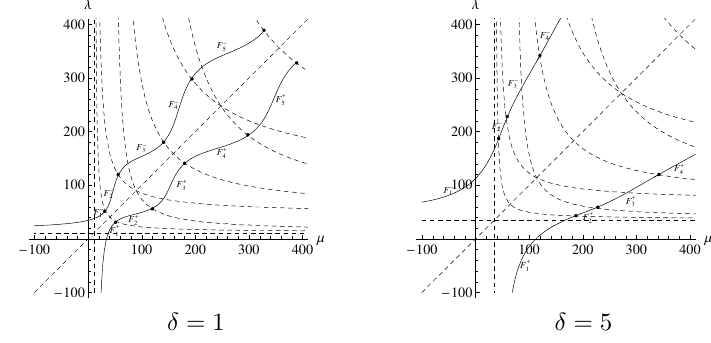
Figure 7. The spectrum of the problem (1.5), (1.6) for some positive δ values.